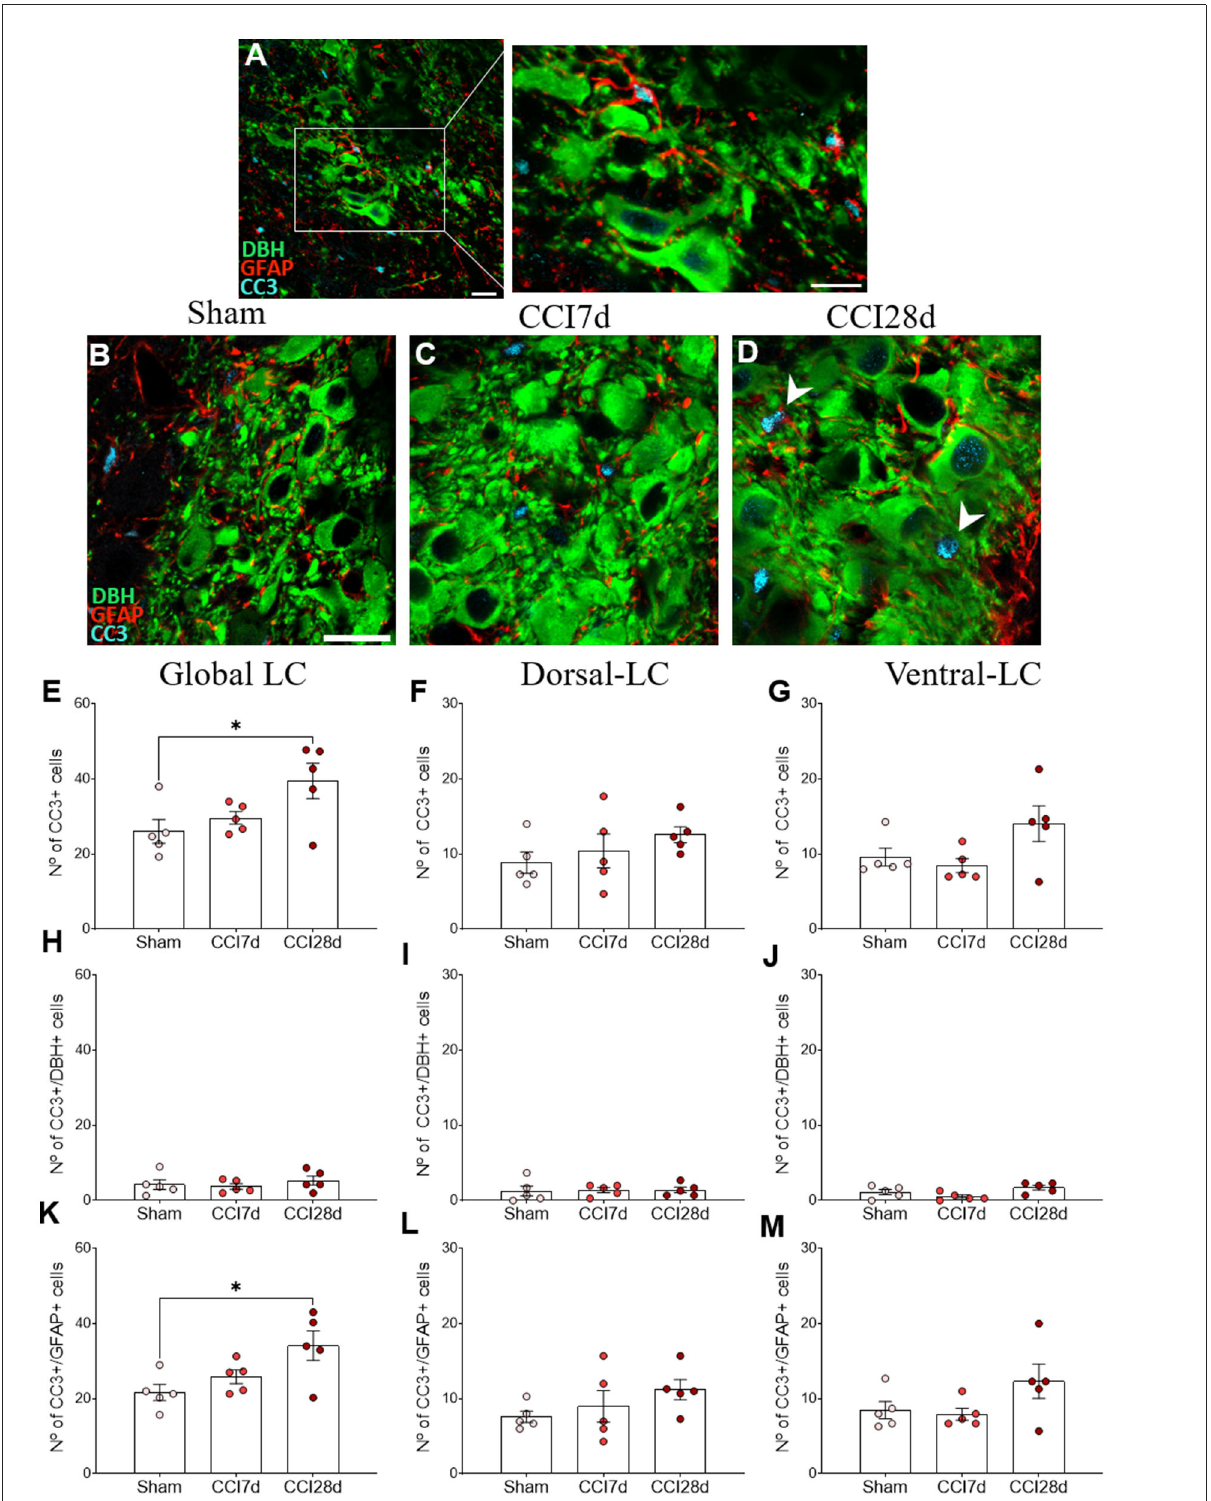
FIGURE8 CC3 expression in DBH + and GFAP + LC cells of neuropathic pain rats. (A) Representative confocal images of CC3 expression in DBH + neurons in the LC of (B) Sham, (C) CCI7d, and (D) CCI28d rats (DBH green; GFAP red; CC3 blue: scale bar, 20 µ m). (E–G) Quantification of the number of CC3 + cells in the (E) global, (F) dorsal, and (G) ventral LC. (H–J) Quantification of the number of CC3 + /DBH + cells in the (H) global, (I)